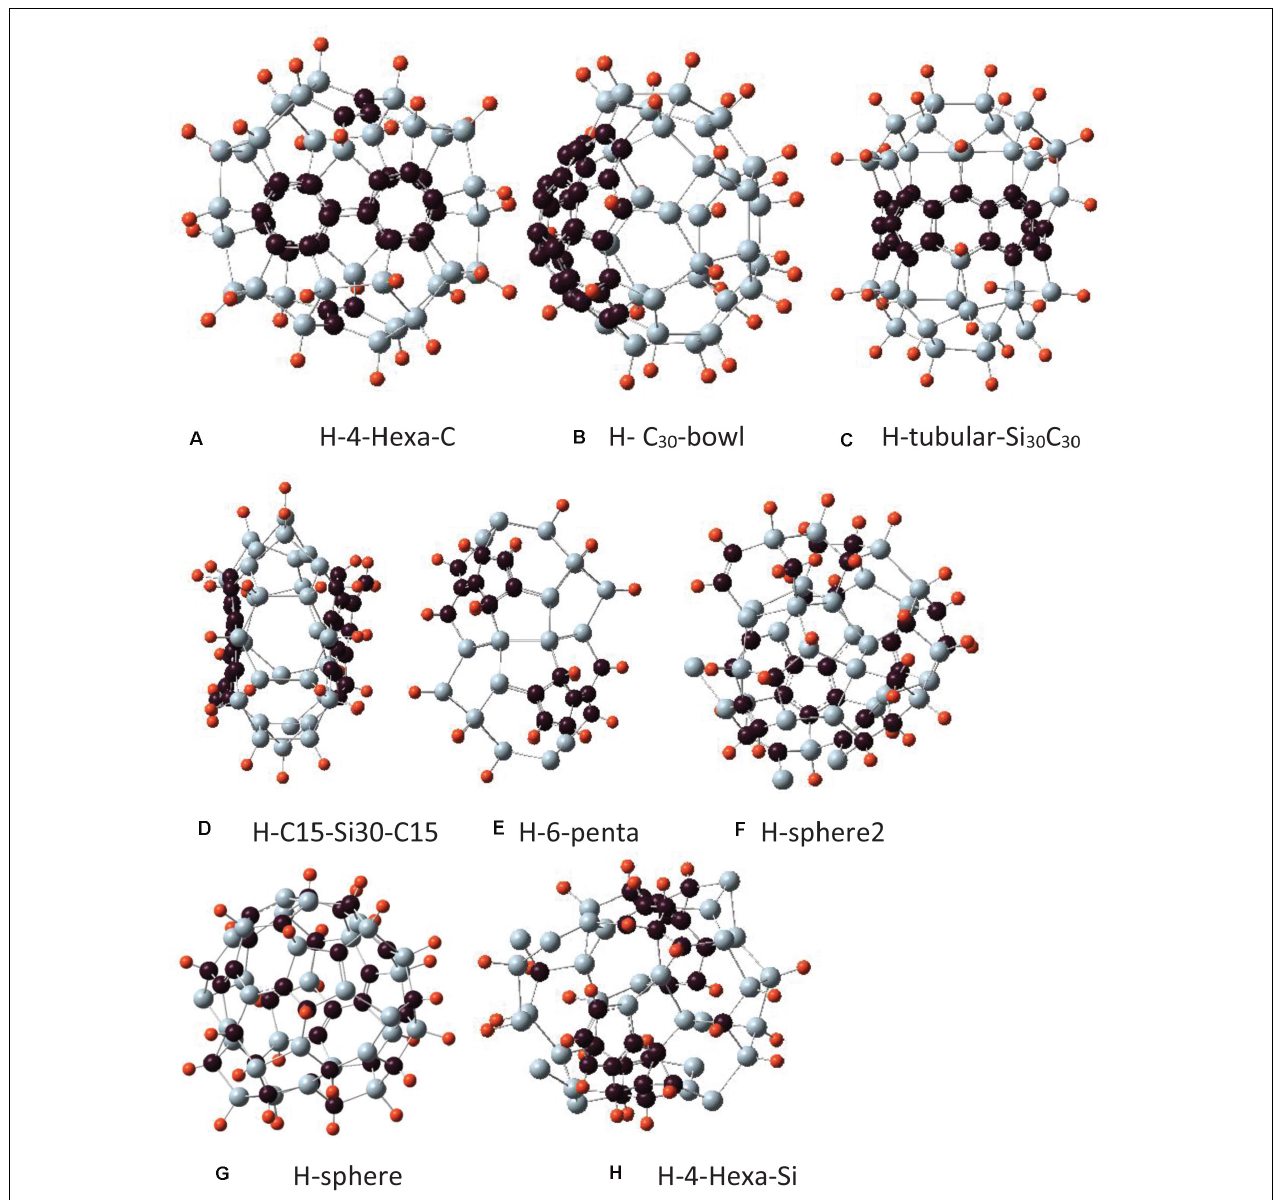
FIGURE 3 | Different isomers of Si 30 C 30 structures with hydrogen passivation, Si 30 C 30 H 30 , where hydrogen atoms bonded with the 3-fold coordinated Si atoms on the Si 30 side of the surface. The Si 30 C 30 configurations and the naming conventions are the same as in Figure 2 . For hydrogen passivation, each cluster name has an H prefix. Structures are presented from panels (A–H) in order of their stability, most to least